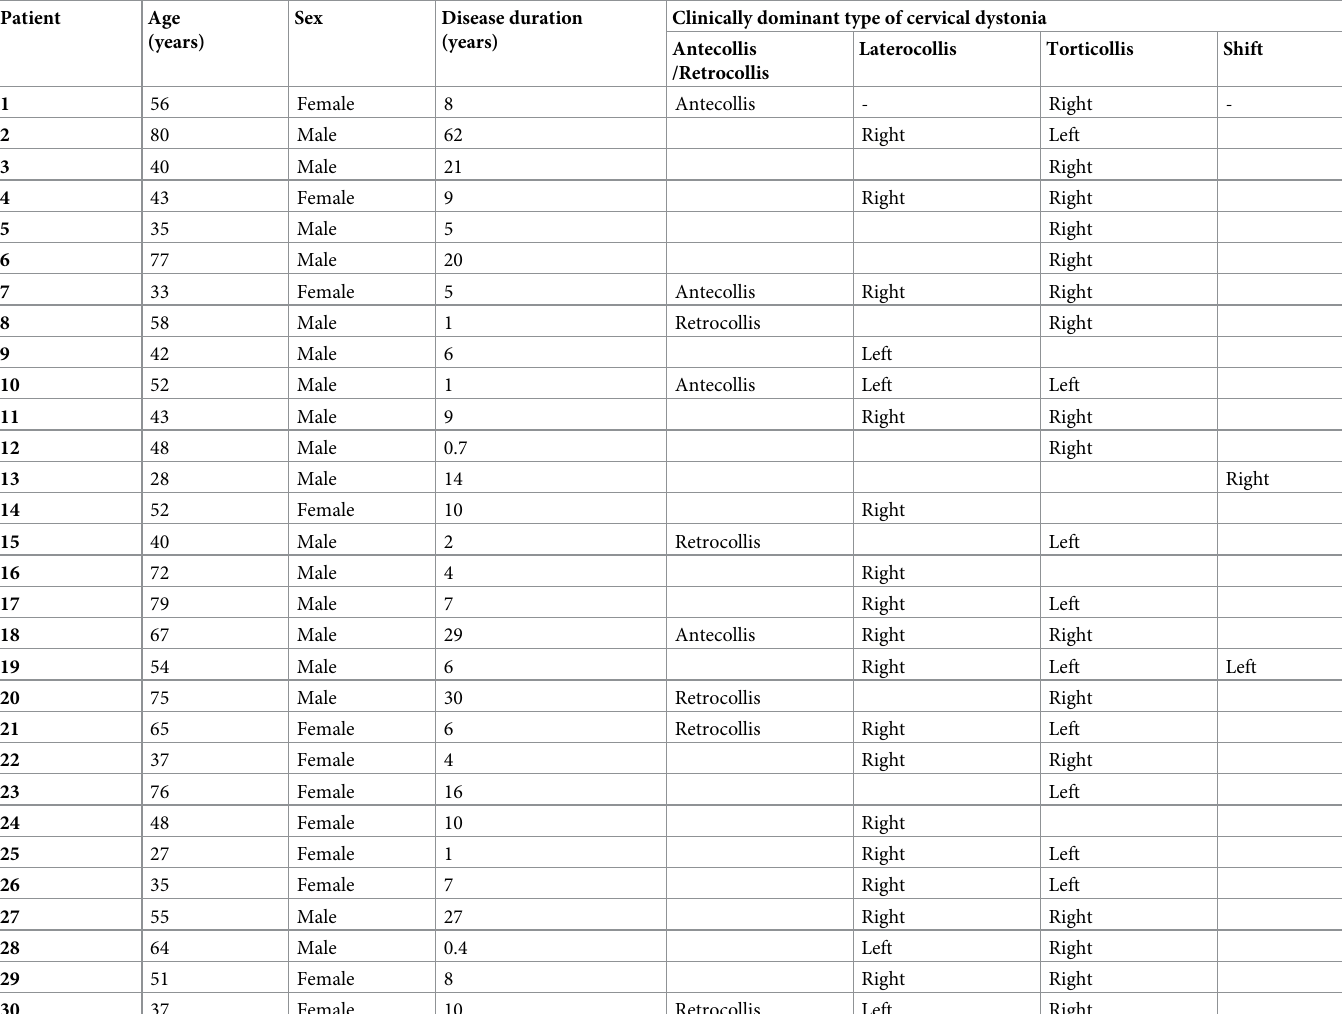
Table 1. Characteristics of